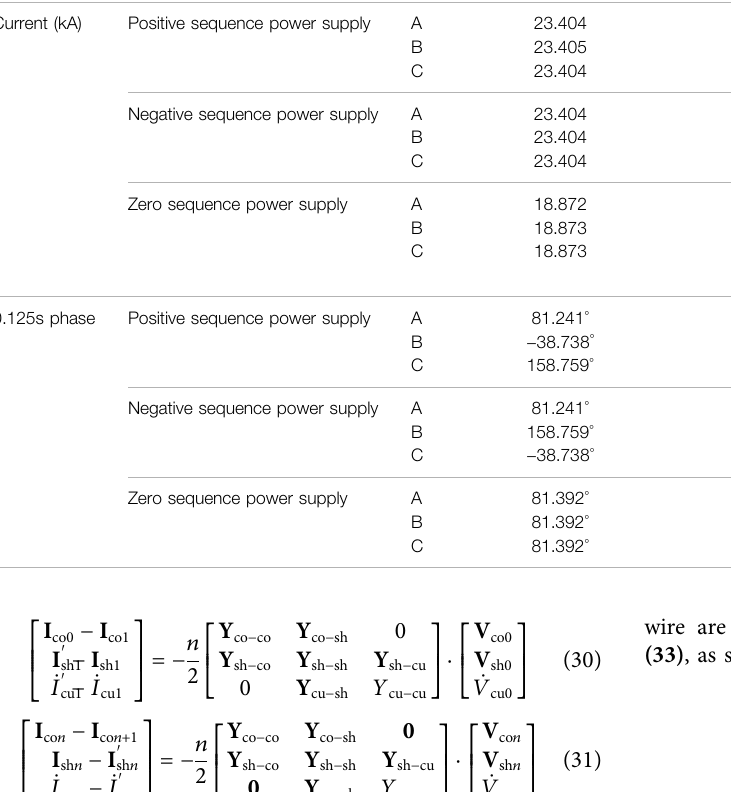
Equivalent parameters of GIL actual parameters Absolute deviation Relative core wire deviation ratio